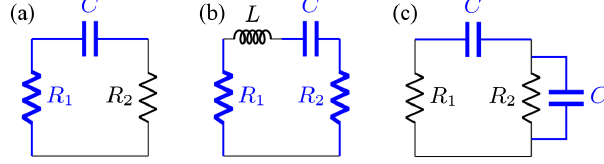
FIG. 2. (a) A simple circuit with diverging local heat currents in the white-noise limit, due to the possibility of high frequency fluctuations originating in one resistor to be dissipated in the other one. (b,c) Two possible modifications, where high fre- quency fluctuations are filtered out by a series inductor (b) or a parallel capacitor (c). The edges of a normal tree in each case are shown in blue. Note that Eq. (58) could be applied to the circuit in diagram (a) to obtain well-behaved quantities; however, they do not represent the actual heat currents. In fact, applying the same equation to the circuit in diagram (b), we obtain the correct heat _ Q k Δ TR=L (for R R R and Δ T ¼ currents h 1 = 2 i ¼ (cid:3) b 1 ¼ 2 ¼ j T 1 − T 2 j ), which diverge in the limit L → 0 . Note that the 0 is able to distinguish the circuits topological condition Q RR ¼ in diagrams (b) and (c) from the circuit in diagram